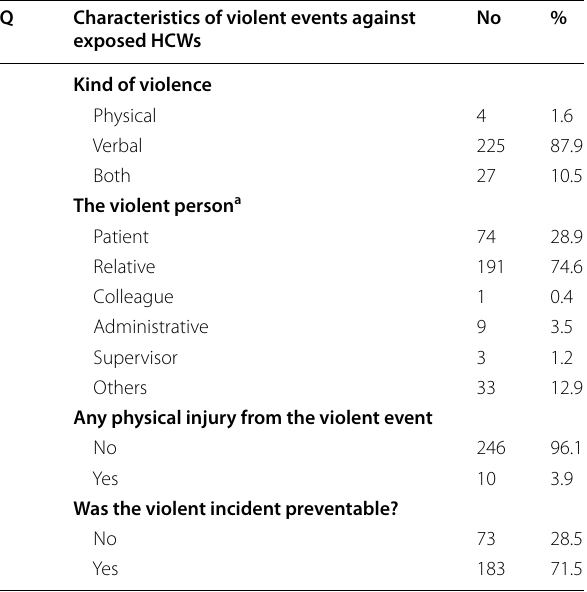
Table 4 Characteristics of violent events against the exposed Egyptian HCWs during the COVID‑19 pandemic in our